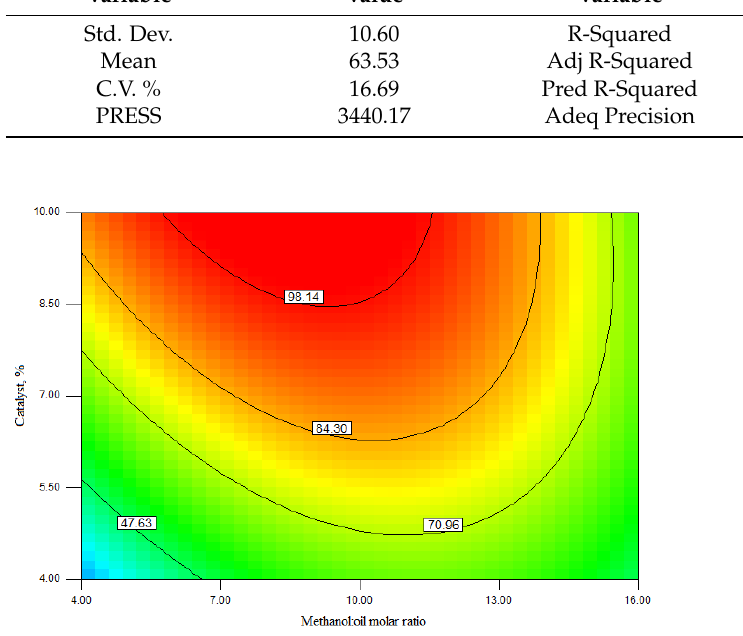
Table 3. Statistical parameters determined using ANOVA for the response surface model. Variable